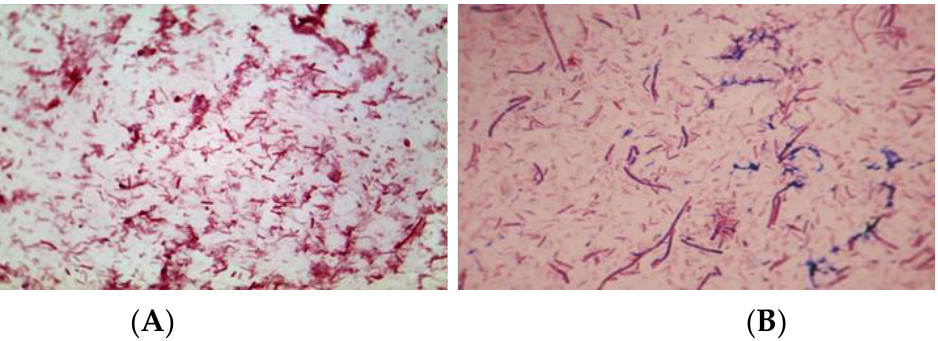
Figure 8. Gram-stained bacterial consortia under the microscopic view, (Leica, DMC4500 Digital Microscope Camera, magnification 1000 × ): ( A ) the consortium in the hydrogenic reactor; ( B ) the consortium in the methanogenic reactor.